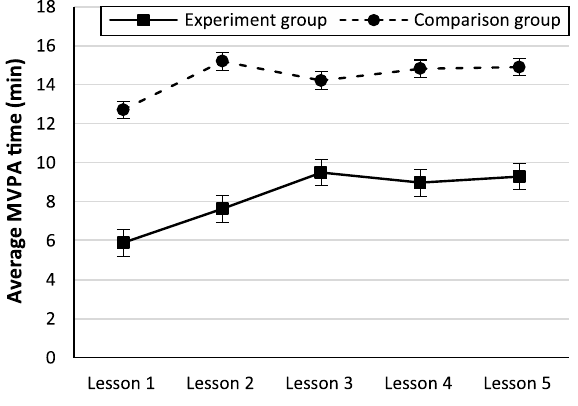
Figure 3. Moderate-to-vigorous physical activity (MVPA) time during the